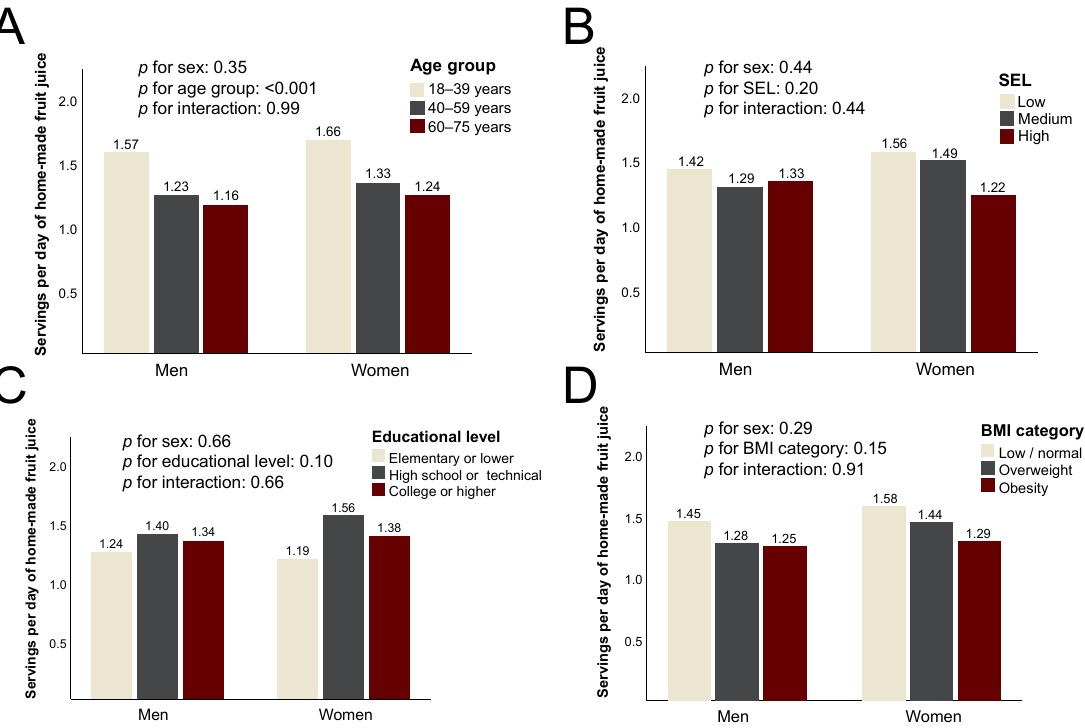
Figure 4. Daily consumption of homemade fruit juice among the study participants. The data are the mean servings per day according to ( A ) age group; ( B ) socioeconomic level (SEL); ( C ) educational level; ( D ) body mass index (BMI) category.